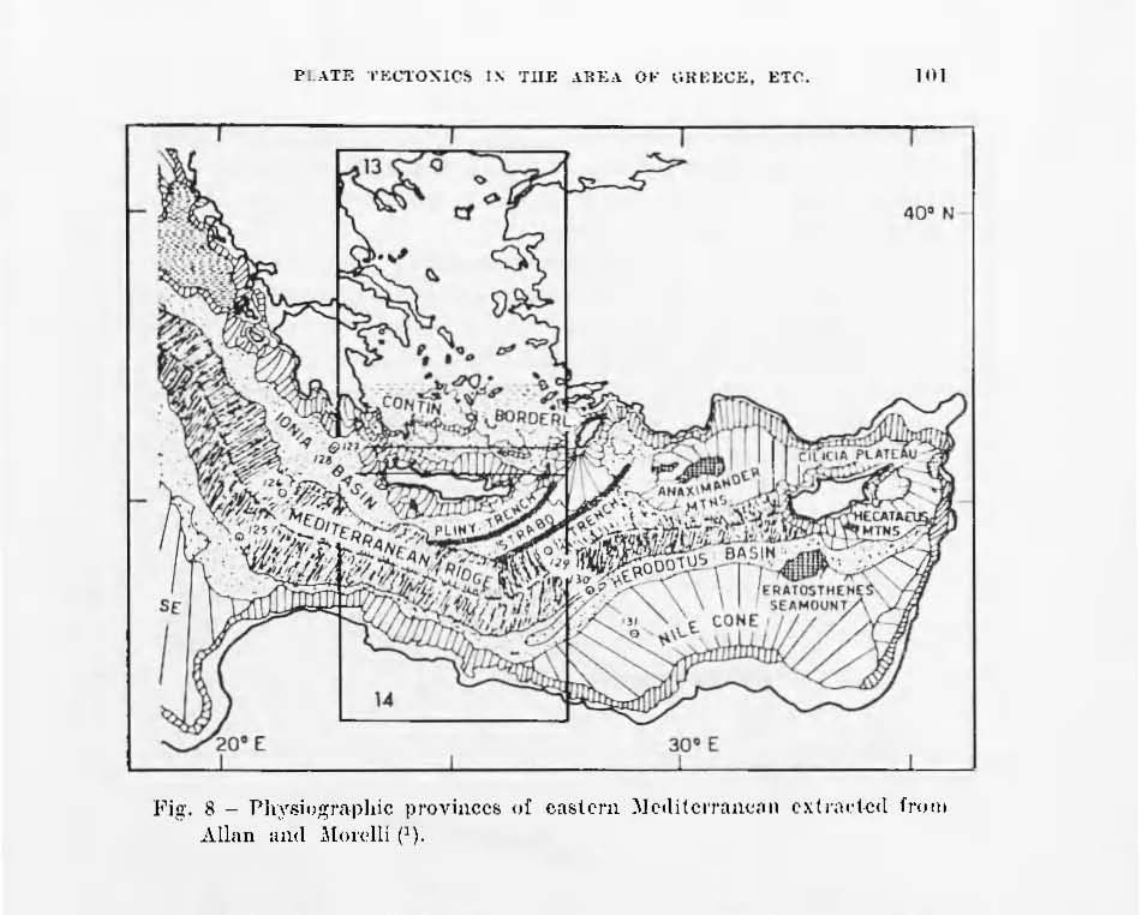
Fig. S - Phy8iographic provillccS or castern :'I]e,litcl"ranl:{l n extrade,l fro'lI Allan aw! lItmdli